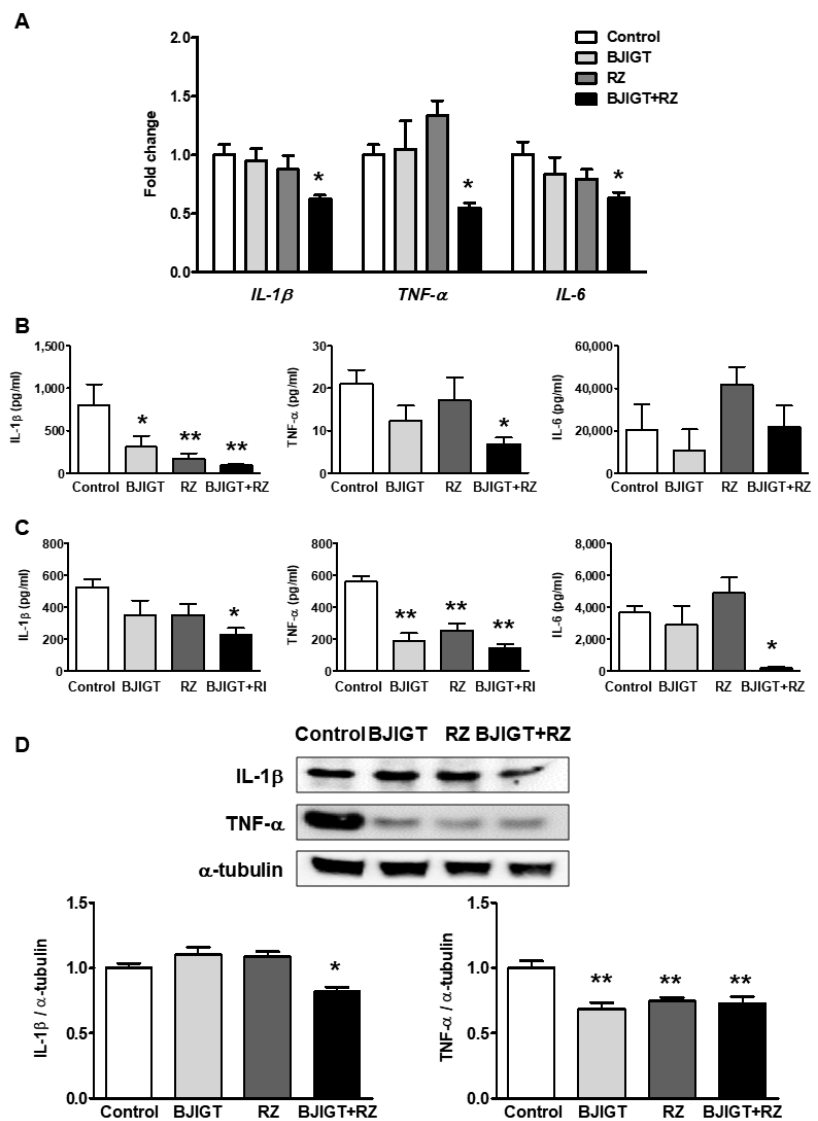
Figure 4. Combined administration of BJIGT and RZ reduced inflammatory cytokines in the serum and liver of hSOD1 G93A mice. ( A ) Gene expression of IL-1 β , TNF- α , and IL-6 in the liver. mRNA was quantified by qPCR, and the resulting values were expressed as relative mRNA expression levels after normalization to GAPDH. ( B , C ) The concentration of inflammatory cytokines (IL-1 β , TNF- α , IL-6) in serum ( B ) and liver ( C ) was determined by a flow cytometry bead-based assay. ( D ) Representative bands of IL-1 β , TNF- α , and α -tubulin expression. Densitometric analysis indicates the quantification of IL-1 β , TNF- α , and transferrin expressed as relative expression levels after normalization to α -tubulin. Data are presented as the mean ± SEM; * p < 0.05, ** p < 0.01, vs. control. n = 5–9 mice per experimental group.